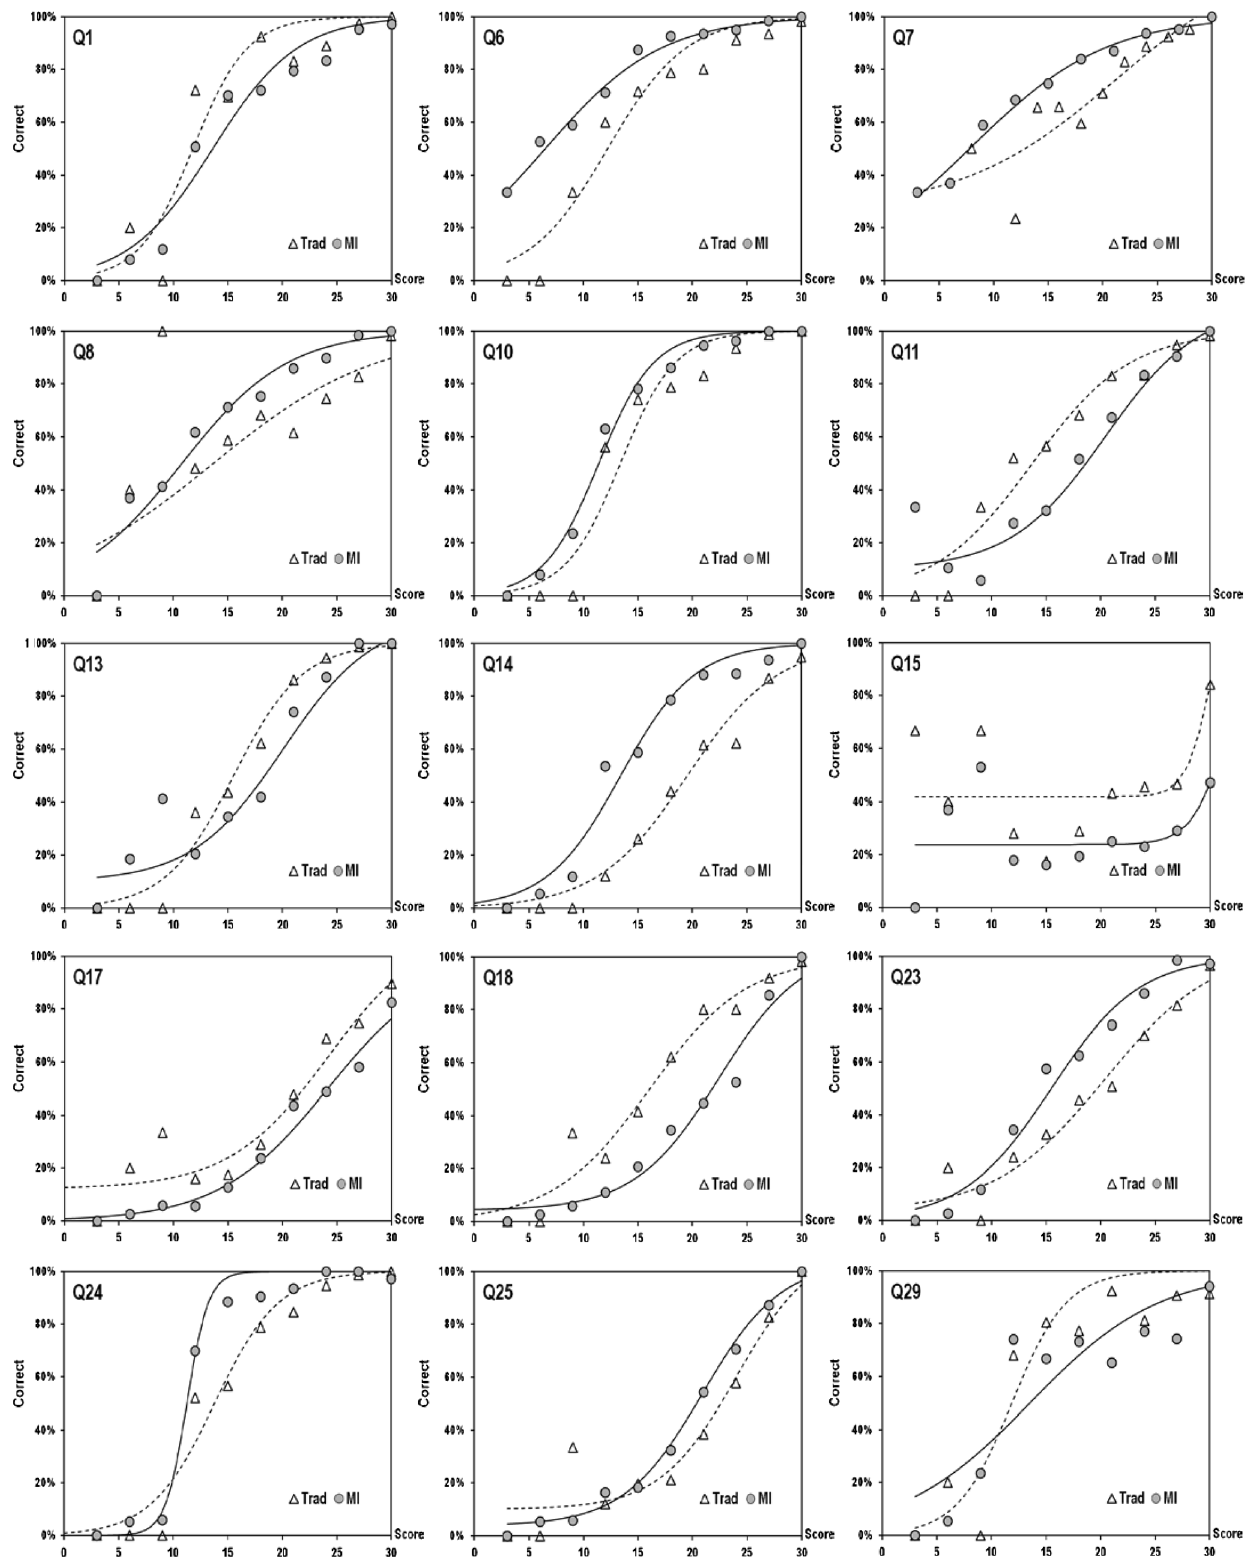
FIG. 4. Item characteristic curves for the FCI items with a significant DIF. The circular and triangular marks represent empirical observations of correct portions for the M&I and PRTC courses, respectively. The solid and dashed curves are regression lines for the M&I and PRTC courses,